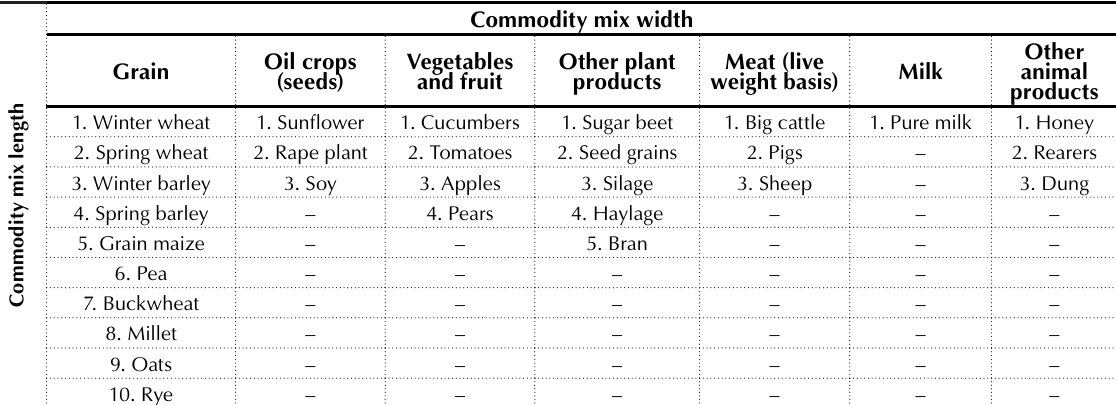
Table 1. Agricultural products nomenclature of the enterprises of Khrystynivka district, Cherkasy region (main